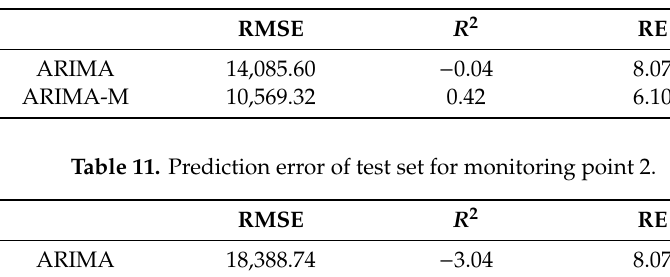
Table 10. Prediction error of test set for monitoring point 1.